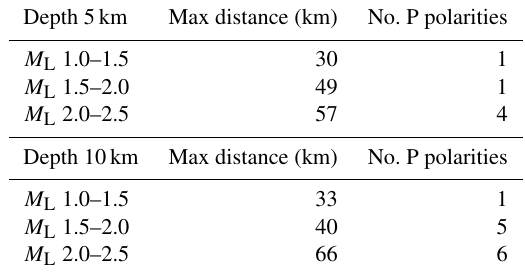
Table 1. Maximum distance of the farthest triggered seismic station and number of P-wave polarities as function of earthquake mag- nitude and depth. The values, empirically derived from the ISNet bulletin, are used for the earthquake